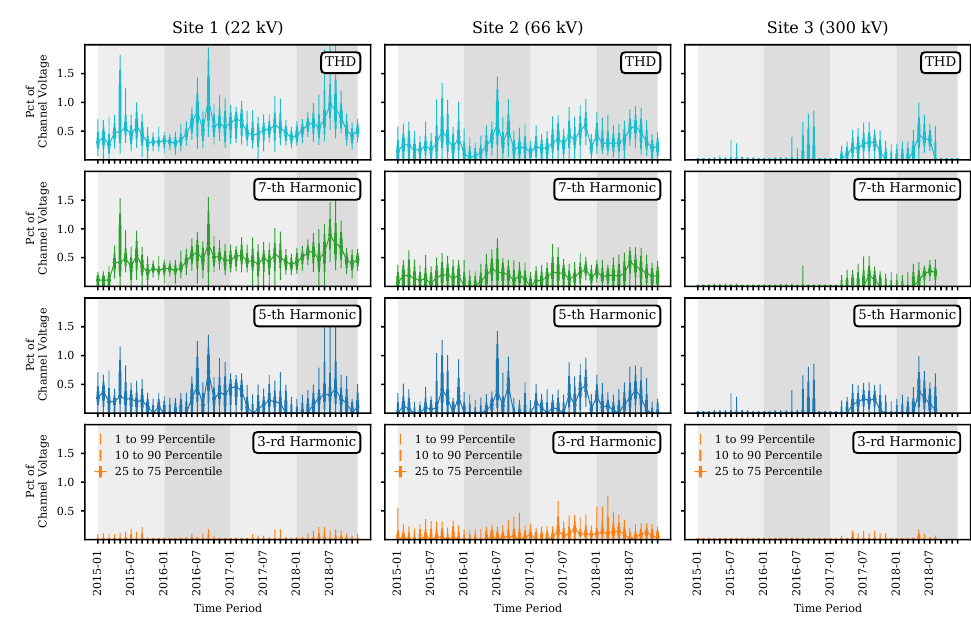
Figure 8. Statistical descriptors of the THD and selected harmonics (rows) aggregated per month for the three sites (columns). For each month, we indicate the median as well as 1, 10, 25, 75, 90, and 99 percentile (see legend). Grey shaded bands indicate the passage of one